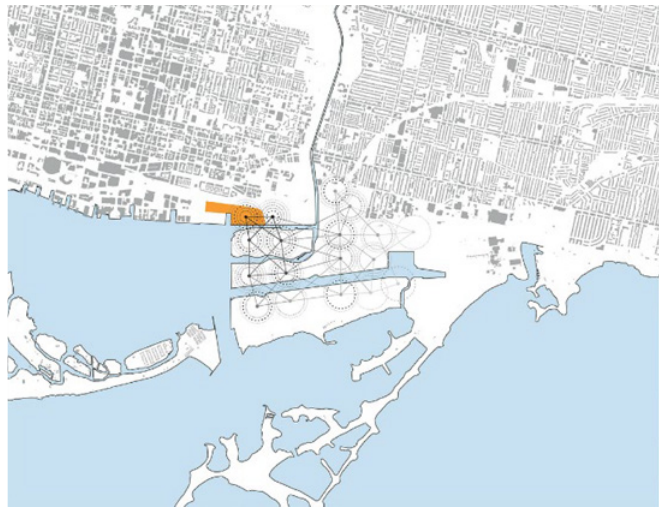
Figure 3 Context. Source: (Sidewalk Labs, 2017, p.13). Credit: Sidewalk